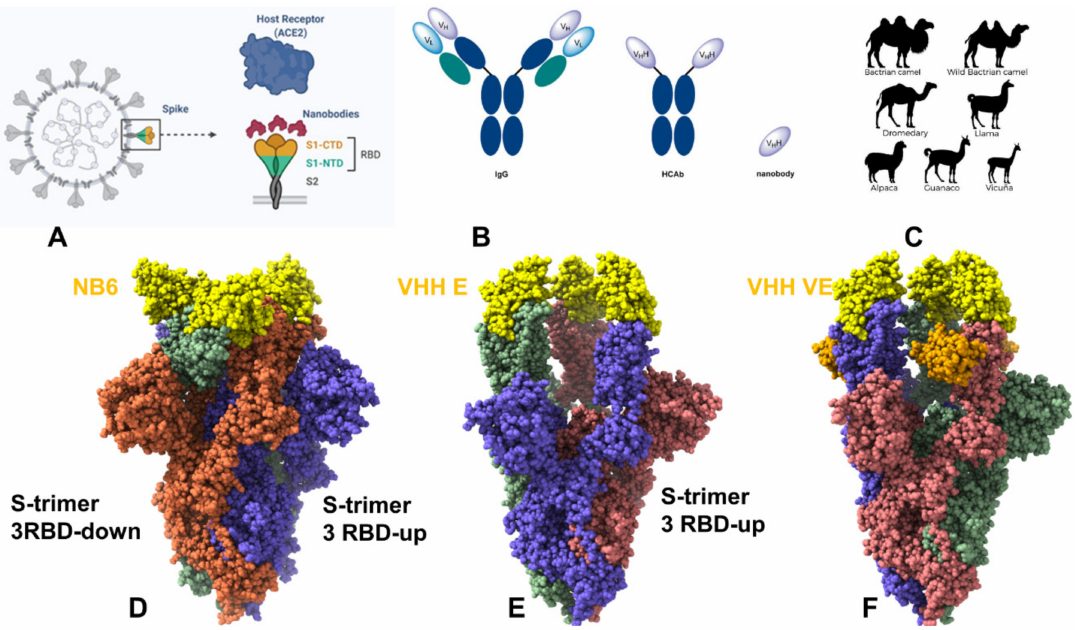
Figure 1. A schematic representation and comparison of conventional antibodies, heavy chain-only anti- bodies, and VHHs nanobodies ( A , B ). Adapted from https://app.biorender.com/biorender-templates (accessed on 3 February 2022). The antigen recognition site of a conventional antibody is formed jointly by the variable regions of the heavy (VH) and light (VL) chains. A nanobody corresponds to the variable region of a heavy chain only antibody. Immunization of camel, llama, alpaca as repertoire source to develop nanobodies ( C ) against interested targets allowed for a growing number of high-affinity nanobodies that effectively target the SARS-CoV-2 S proteins and induce effective neutralization. Cryo- EM structures of the SARS-CoV-2 S trimer in the complex with Nb6 nanobody, pdb id 7KKK. Nb6 nanobodies are shown in yellow ( D ). The SARS-CoV-2 S trimer in the complex with VHH E nanobody, pdb id 7KSG. VHH E is in yellow spheres ( E ). The SARS-CoV-2 S trimer in the complex with VHH V/VHH E nanobody, pdb id 7B18. VHH VE is in yellow/orange spheres. VHH E part in yellow and VHH V is in orange ( F ). The structures are shown in full spheres with protomers A,B,C colored in green, red, and blue. The rendering of SARS-CoV-2 S structures was done using the interactive visualization program UCSF